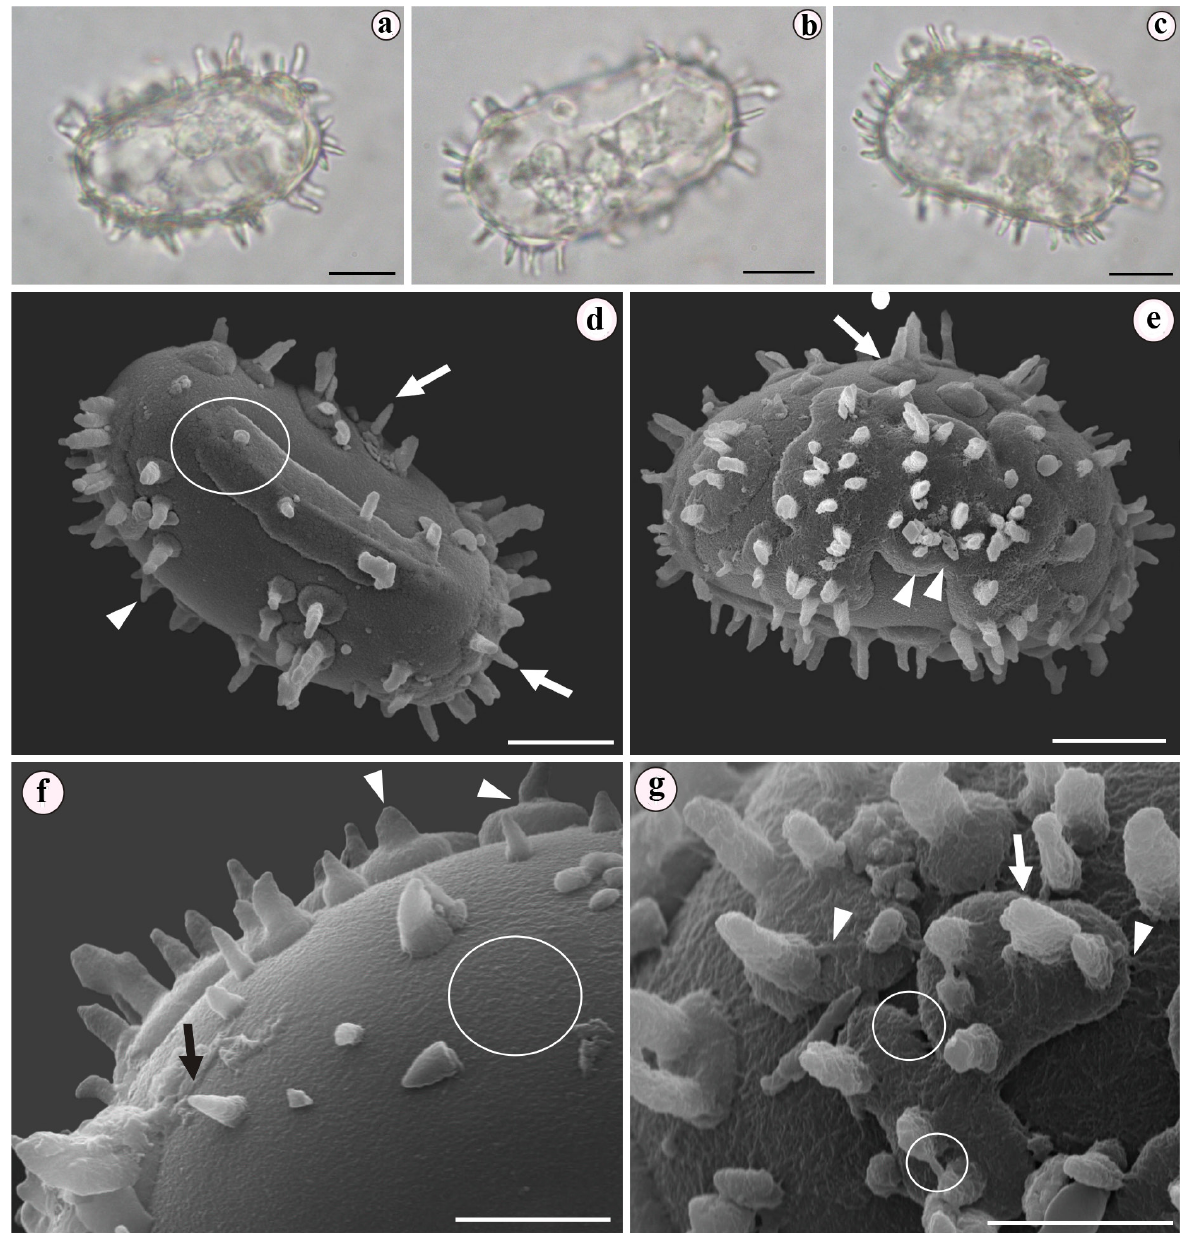
Figure 1 - Spores of Blotiella lindeniana with LM and SEM. Baculate sculpture. Figs. a-c. Spores with LM. a. Proximal view. b. Distal view. c. Equatorial view. Figs. d-g. Spores with SEM. d. Spore in proximal view. The sculpture is baculate, with bacula distributed at random on the surface (arrows). Echinae ocassionaly are observed (arrowhead). Lesurae are covered by thickenings of the perispore (circle). e. Spore in distal view. A thickening at the base of each baculae is present forming mamelons (arrow). Those thickenings sometimes are fused (arrowheads). f. Detail of the equatorial surface. Few echinae are observed (arrow). A thickening at the base of each baculae can be seen, which forming mamelons (arrowhead). The spores surface is microverrucose (circle). g. Detail of equatorial surface. The bacula are elliptical in section (arrow). There are threads on the spore surface (arrowheads), which connect the ornamentation elements (circles). Scale bars: a, b, c, d and f = 10 µm; e and g = 5